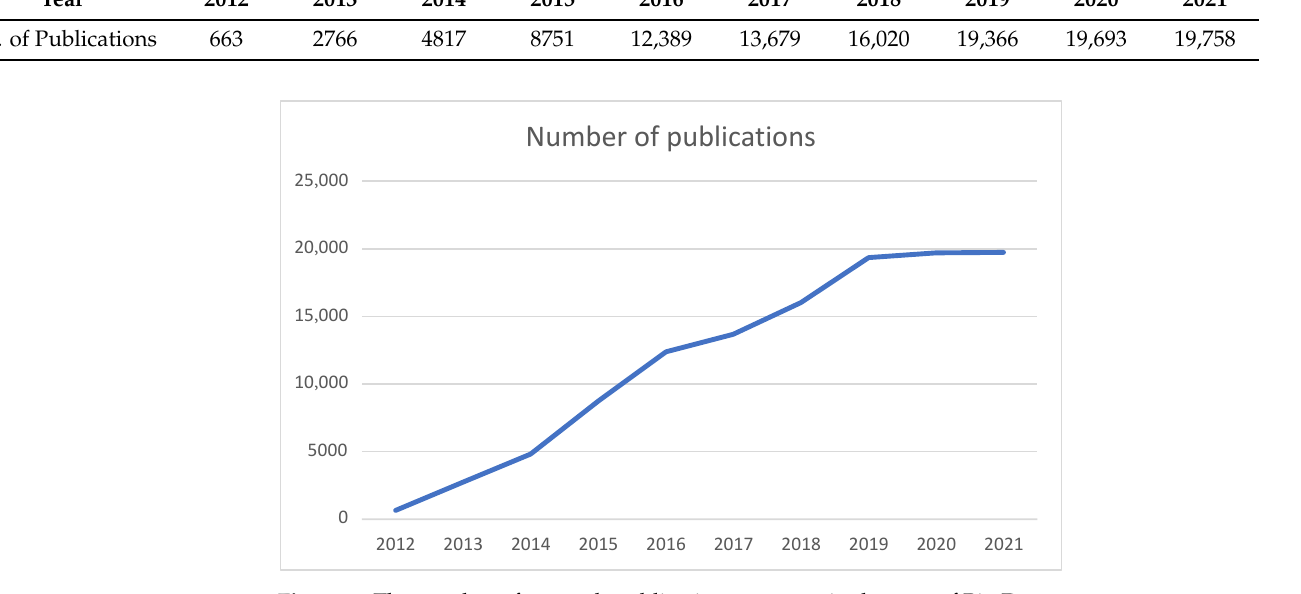
Figure 1. The number of research publications per year in the area of Big Data.